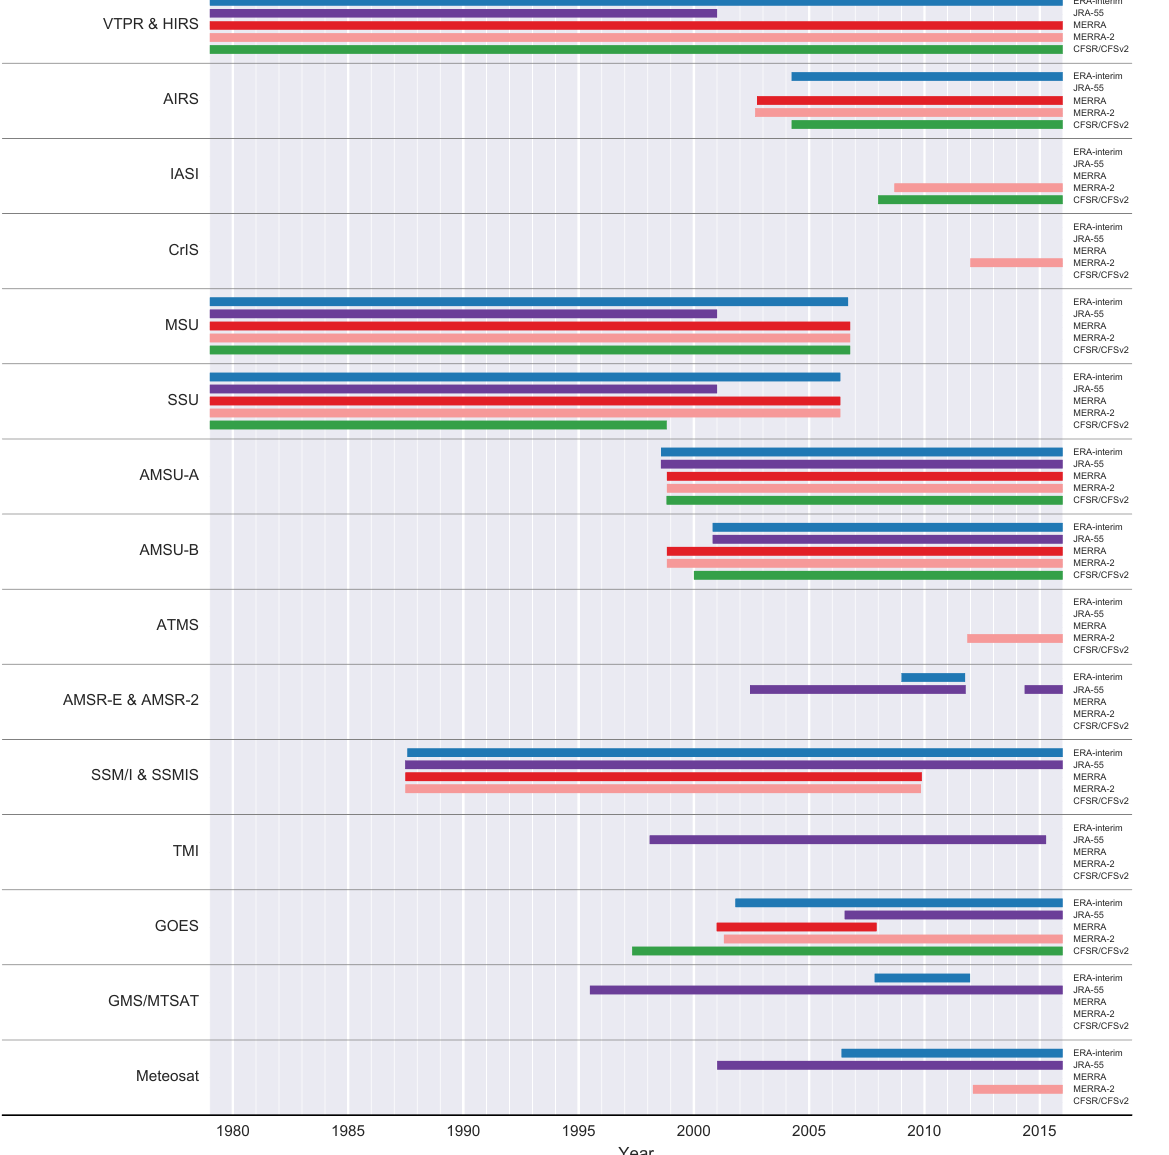
Figure 8. As in Fig. 6, but for satellite radiance observations assimilated by the reanalysis systems. See Appendix A for abbreviation